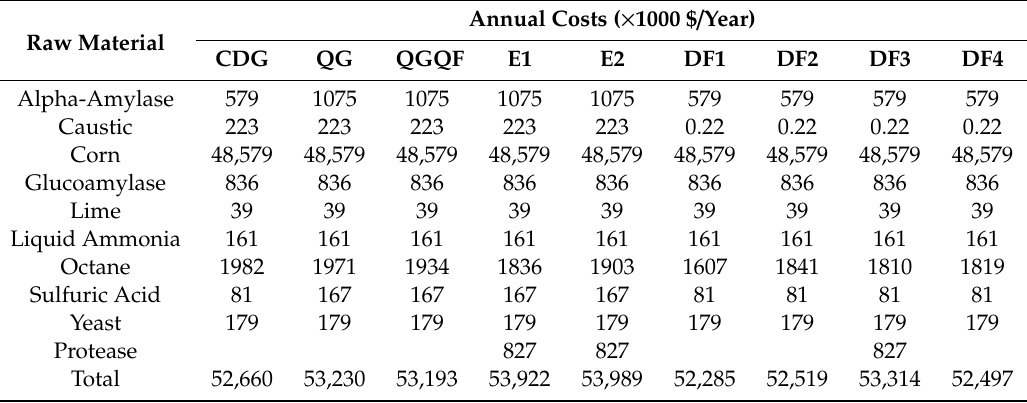
Table 3. Summary of raw material costs in conventional and modified dry grind